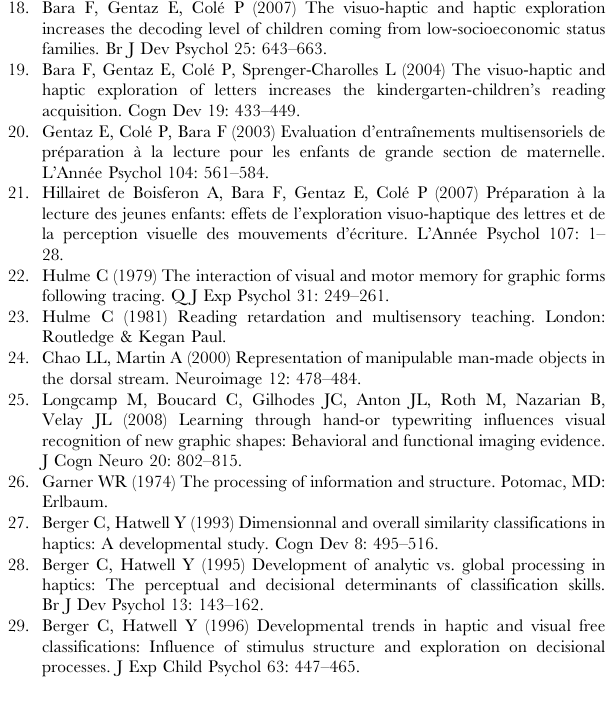
learning method and delay. The dotted line corresponds to the level of chance performance. Found at: doi:10.1371/journal.pone.0004844.s001 (2.11 MB TIF) Figure S2 Mean number and standard error of visuo-auditory and audio-visual associations correctly recognized (maximum 15) as function of learning method and delay. The dotted line corresponds to the level of chance performance. Found at: doi:10.1371/journal.pone.0004844.s002 (2.10 MB TIF) Figure S3 Mean number and standard error of visuo-auditory and audio-visual associations correctly recognized (maximum 15) as function of learning method. Found at: doi:10.1371/journal.pone.0004844.s003 (2.11 MB TIF) Figure S4 The 15 visual/haptic stimuli used in both learning methods. Found at: doi:10.1371/journal.pone.0004844.s004 (0.07 MB TIF) Figure S5 Eight examples of stimuli used as visual distractors in immediat and delayed intramodal recognition tests. Found at: doi:10.1371/journal.pone.0004844.s005 (0.06 MB